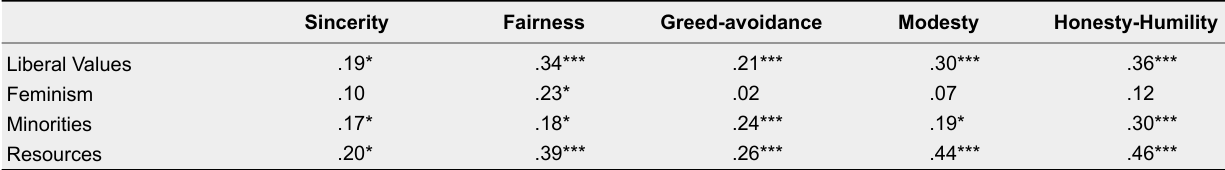
Correlations Between Honesty-Humility and Liberal Values Honesty-HumilityModestyGreed-avoidanceFairnessSincerity Liberal